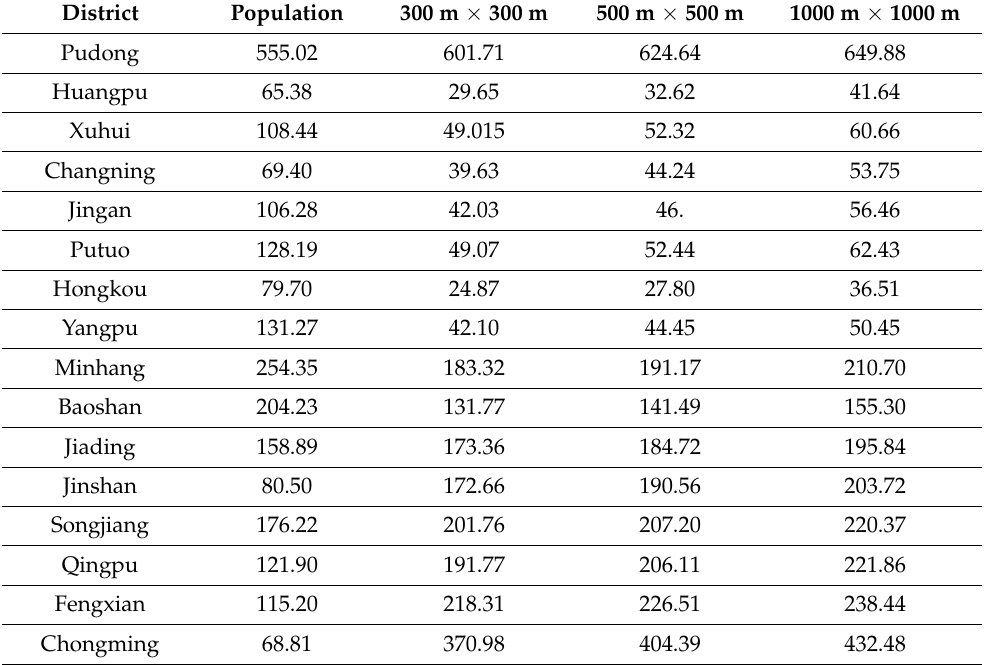
Table 2. Total population and carrying capacity of each district in Shanghai of 2018 (unit: 10,000